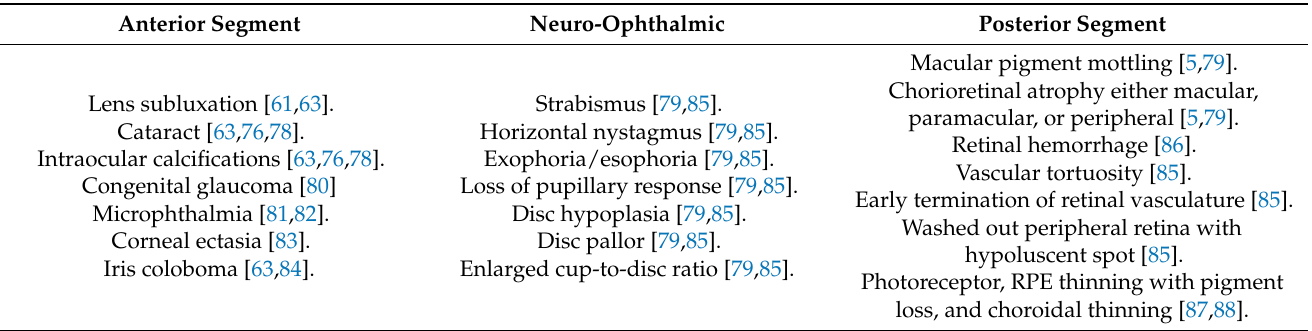
Table 2. Ocular findings documented in